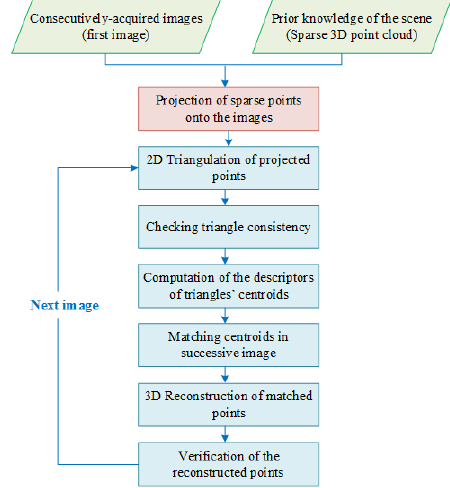
Figure 1. The outline of the proposed incremental 3D dense reconstruction